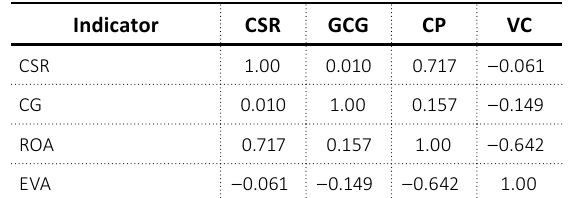
Table 2. Variable definitions and data